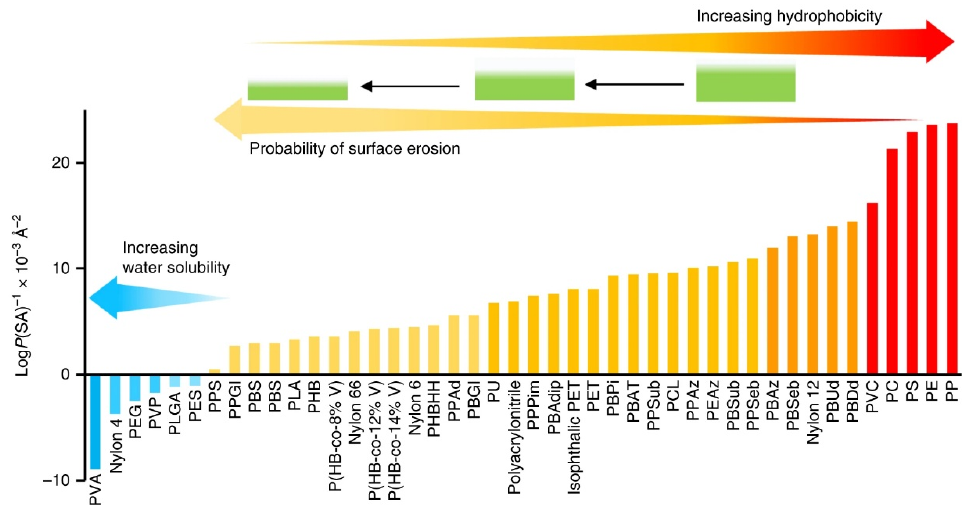
Figure 4. The wide range of hydrophobicity of plastics [62].